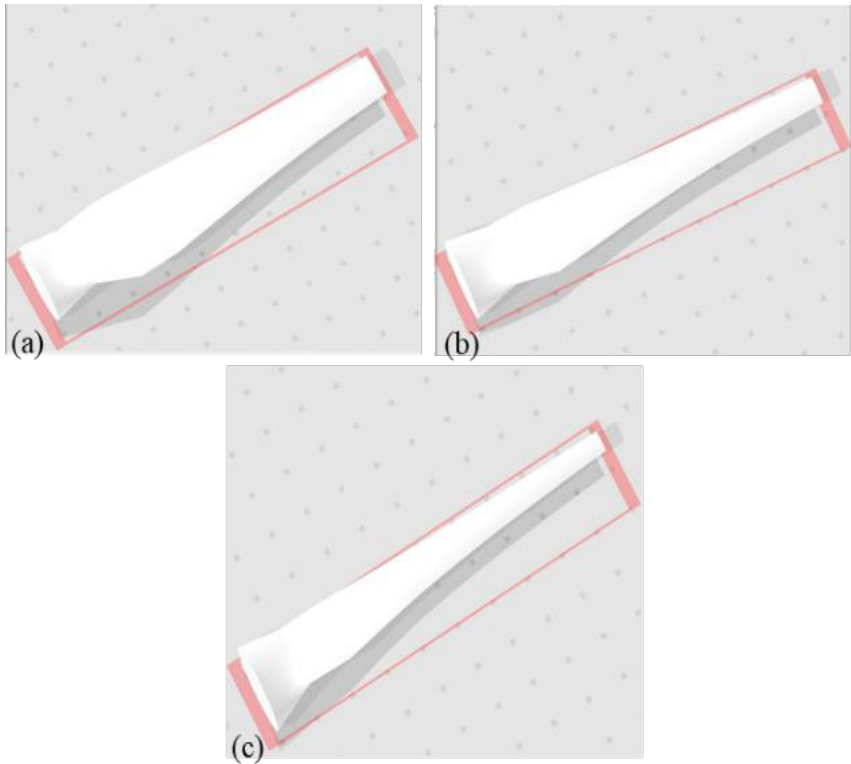
Figure 12. 3-D blade model designed with NACA 4412 airfoils for ( a ) TSR 4; ( b ) TSR 5; ( c ) TSR 6.